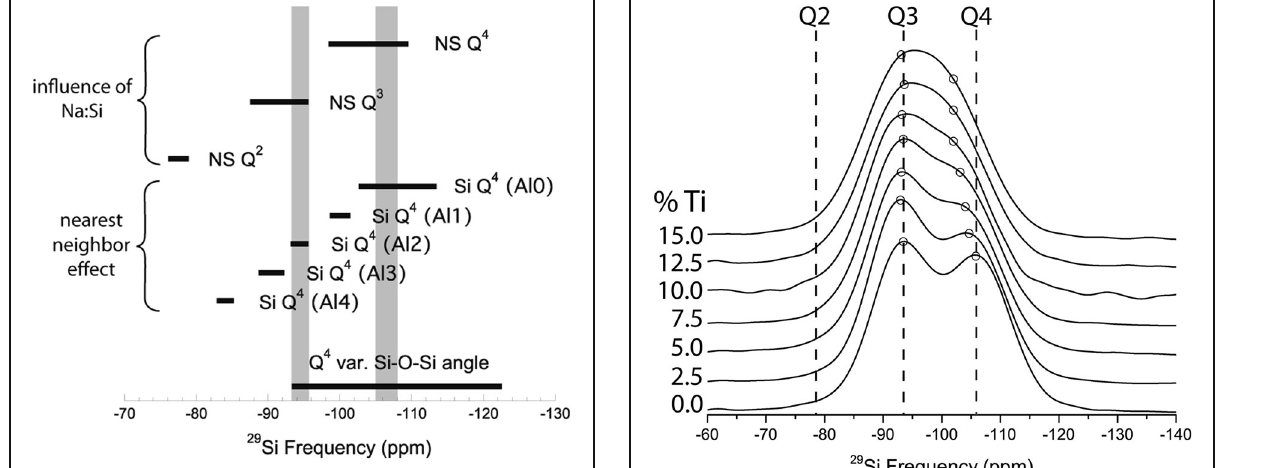
Fig. 2 Factors influencing peak positions of Q-species in 29Si NMR spectra. Grey vertical bars are the peak frequencies observed in the present study. The number of non-bridging oxygens (number of Si – O – Na interactions) causes a positive shift in peak frequency, such that Si in Q 2 speciation (2 non-bridging oxygens) is at a higher frequency than Si in Q 4 speciation (0 non-bridging oxygens). For Si in Q 4 speciation, Al as a network-forming cation nearest neighbor has been shown to cause a shift toward higher frequency. Q 4 Si with one Al nearest neighbor (Al1) is at a lower frequency than Q 4 Si with 4 Al nearest neighbors (Al4). Variations on Si – O – Si bond angle can also induce large shifts in the Q 4 peak position, shown here from lower frequency ( − 122 ppm at 170°) to higher frequency ( − 93 ppm at 130°). These variations in bond angle are the cause of the Al nearest neighbor effects (Lippmaa et al. 1981)